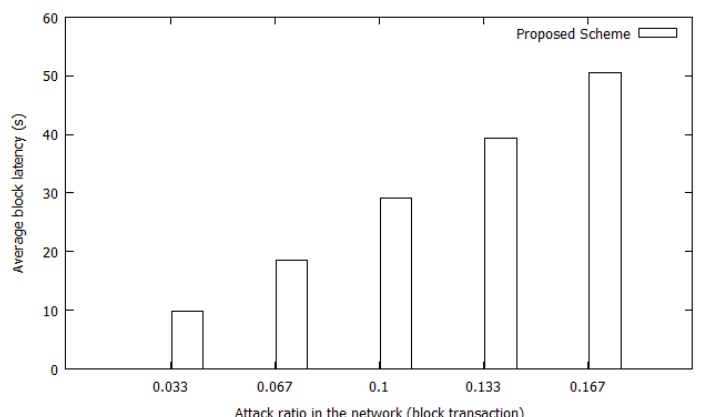
Figure 13. Block Generation Latency Based on Attack